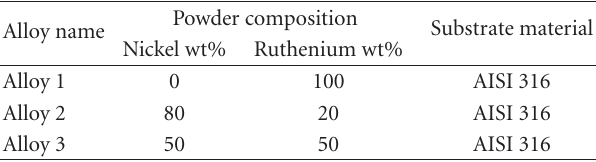
Table 1: Composition of the powders used on sample.